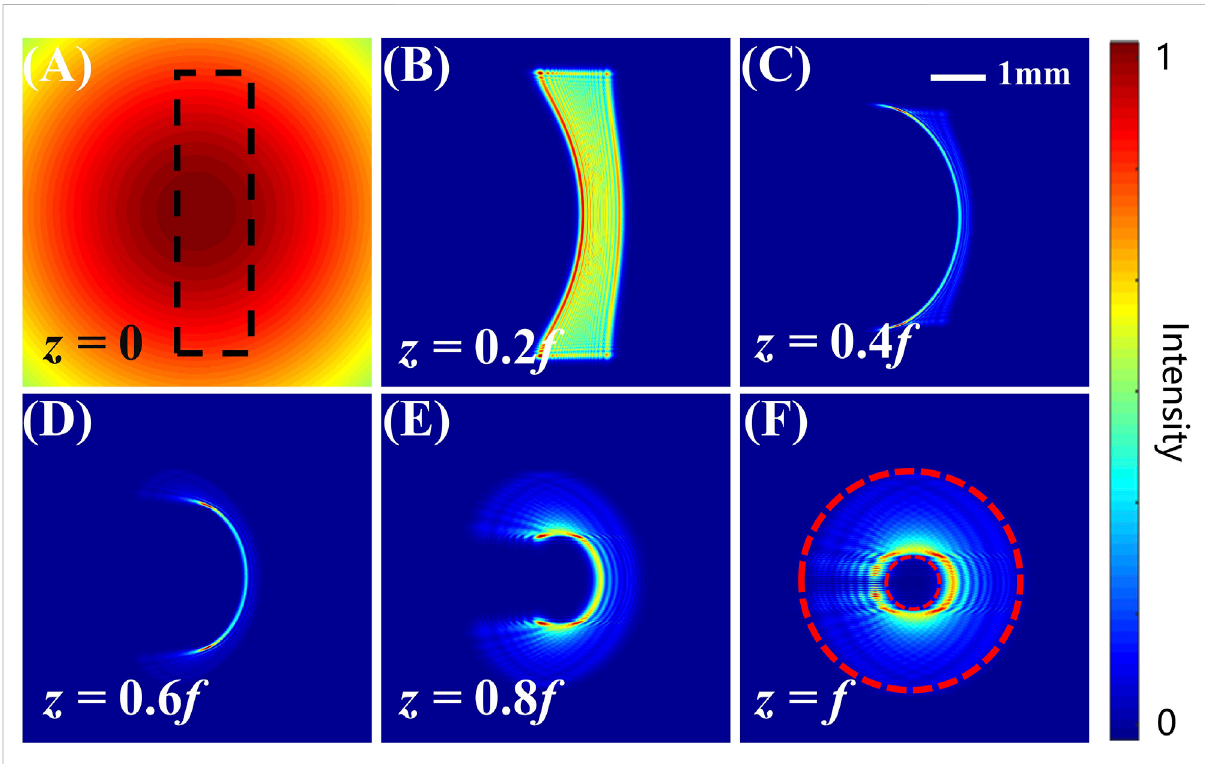
FIGURE 2 Propagation process for the GCT. (A) Input Gaussian beam, with the transmission area marked by the dashed rectangle. (B – F) Intensity distributions at different propagation distances.